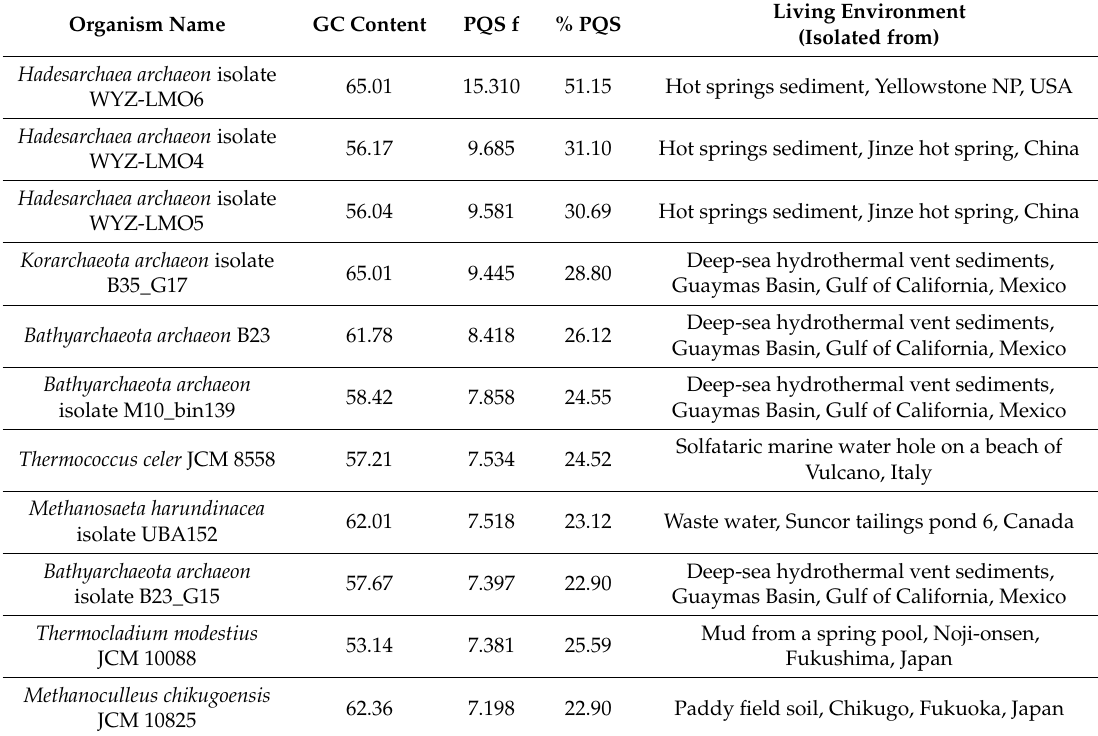
Table 5. Detailed characteristics of archaeal species with PQS frequency per 1000 bp greater than 6.00. Living environments data were obtained from the BioSample NCBI database